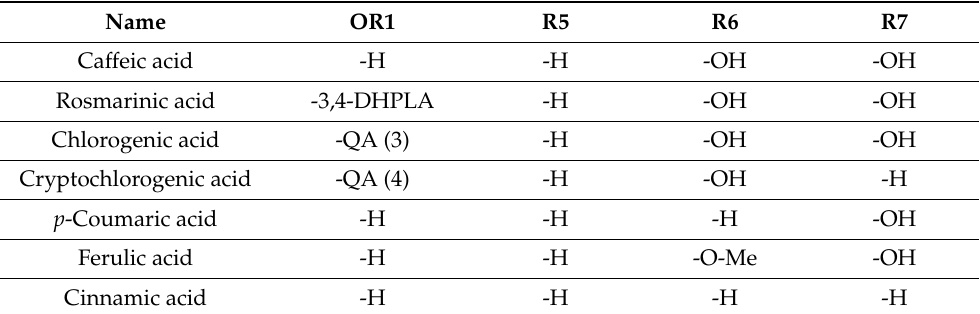
Table 3. Hydroxycinnamic acid and its derivatives reported in clover plants and honey (see Figure 4 for general structure).